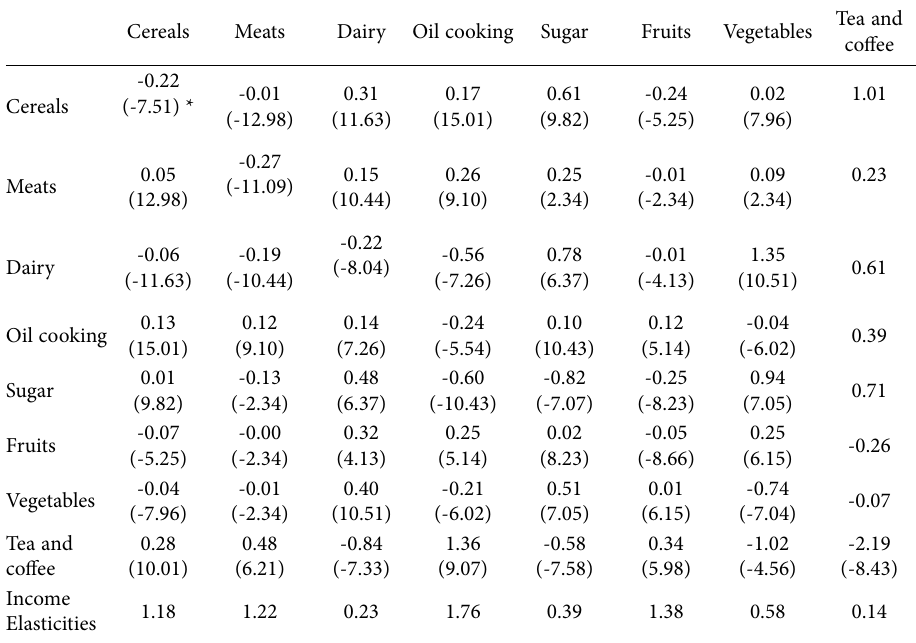
Table 2. Hicksian (Compensated) Price and income elasticities for different food groups. Cereals Meats Dairy Oil cooking Sugar Fruits Vegetables